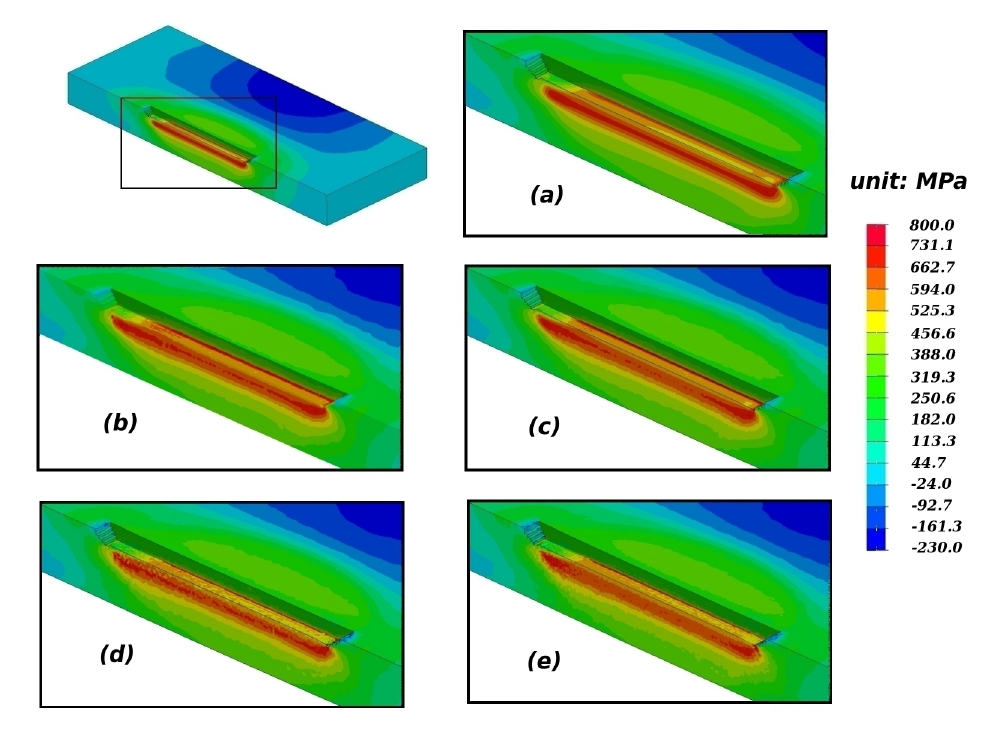
Figure 8. Longitudinal σ yy residual stress for ( a ) Q1P0 elements, ( b ) P1P1 elements with mesh B, ( c ) P1P1 elements with mesh C, ( d ) nodal approach with mesh B, ( e ) nodal approach with mesh C (unit: MPa) at t = 1000